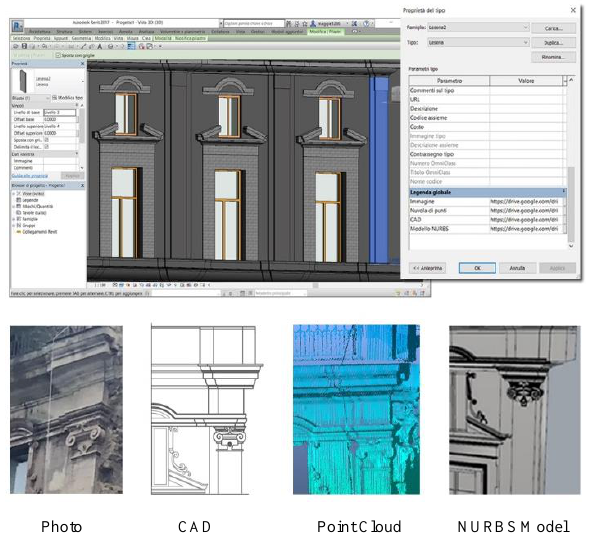
Figure 7. Every type of information has been linked to HBIM model.